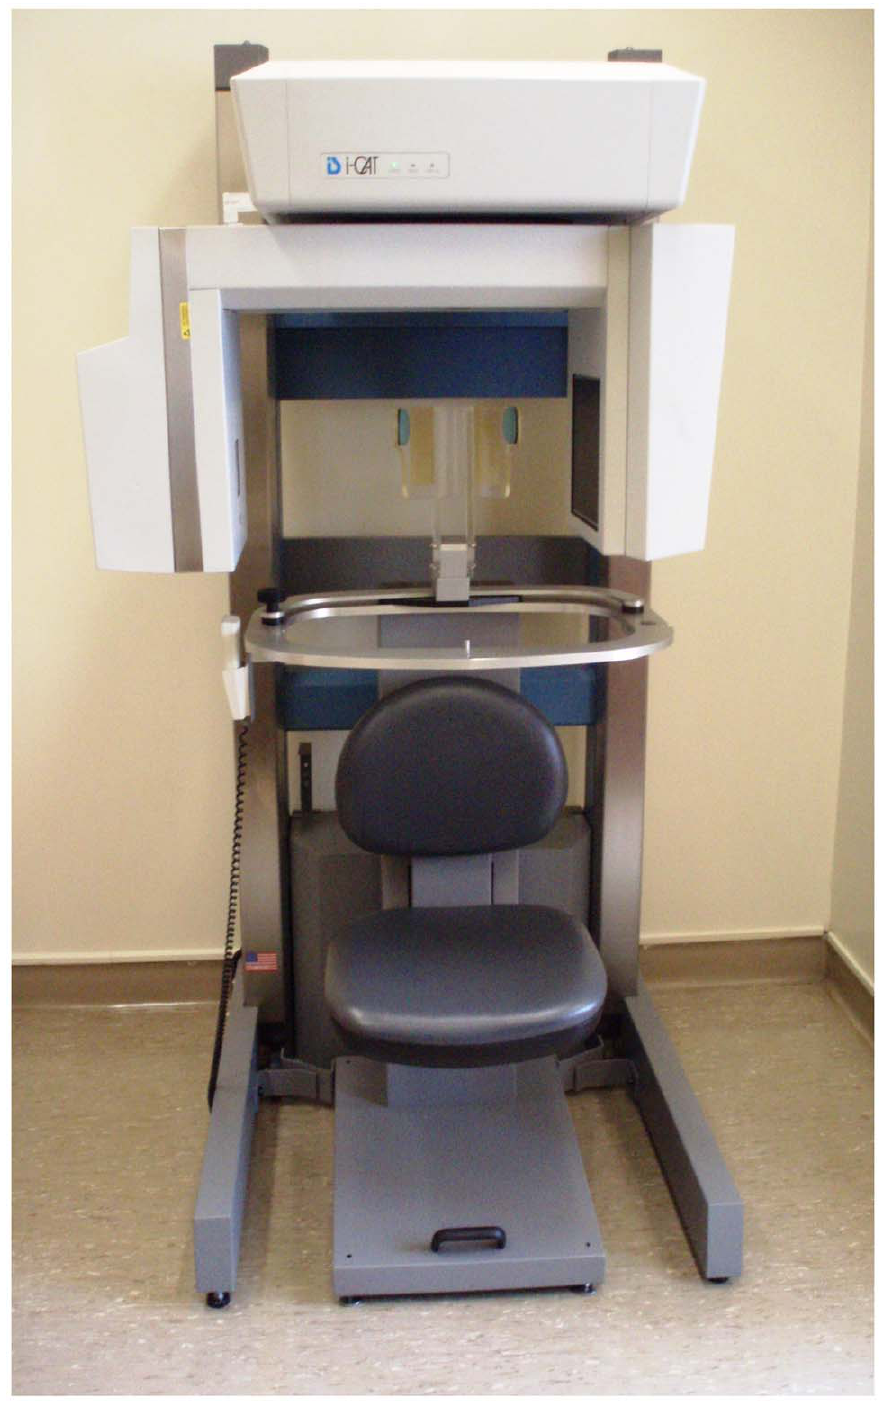
Figure 3. The i-CAT Cone-beam CT scanner.